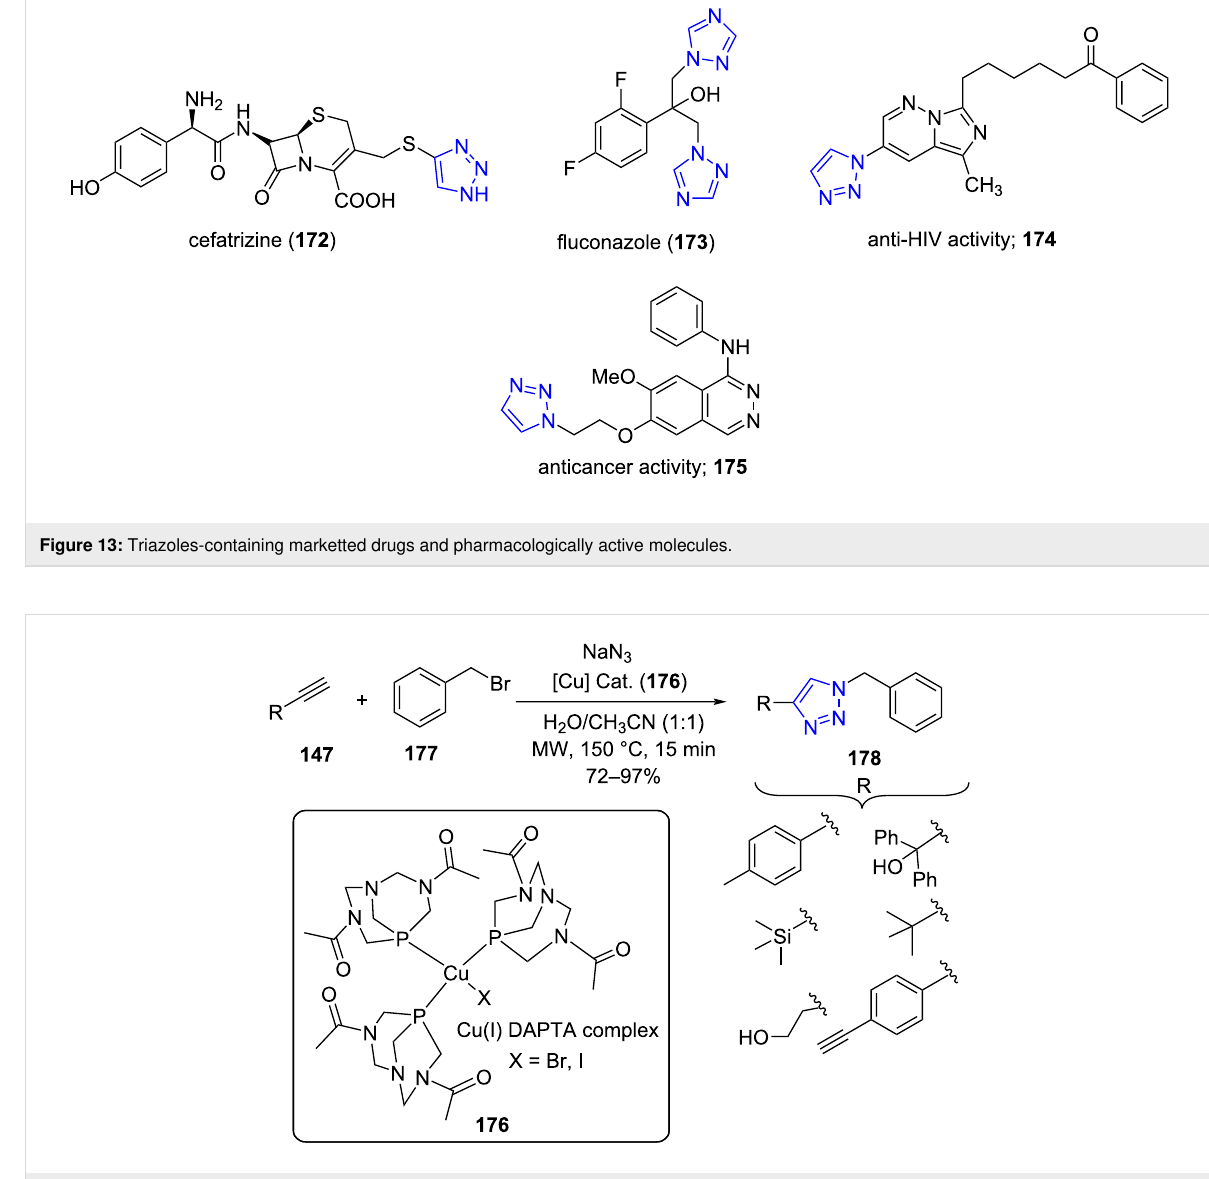
Scheme 73: Cu(I) DAPTA-catalyzed 1,2,3-triazole